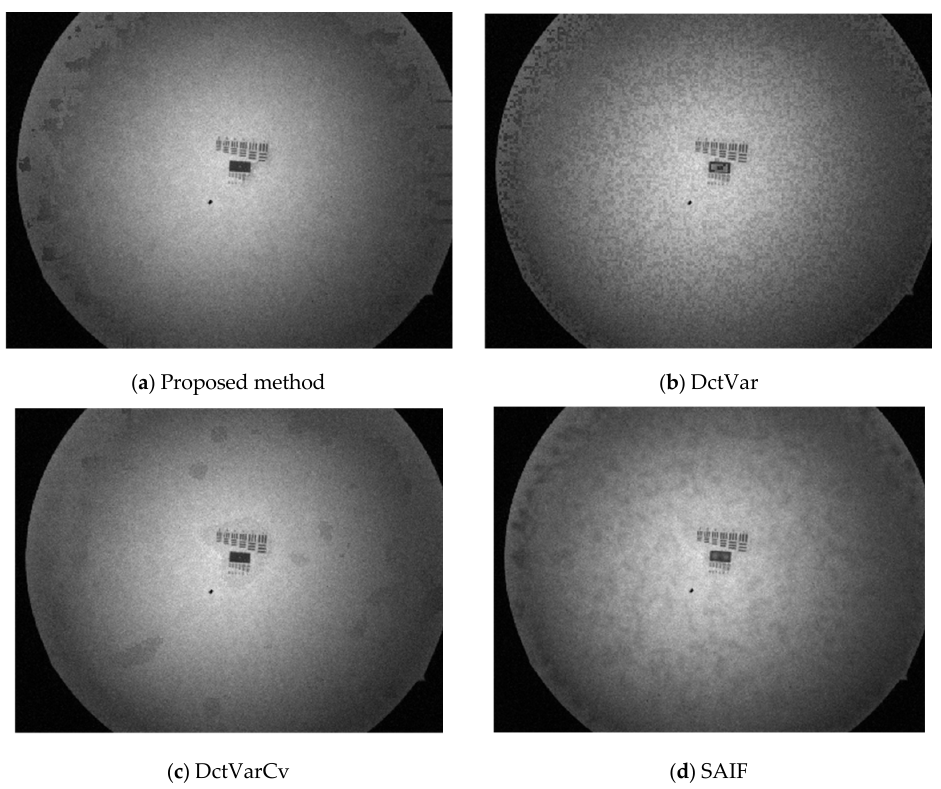
Figure 18. The fusion result of the NVG image (63 and 96 degrees).